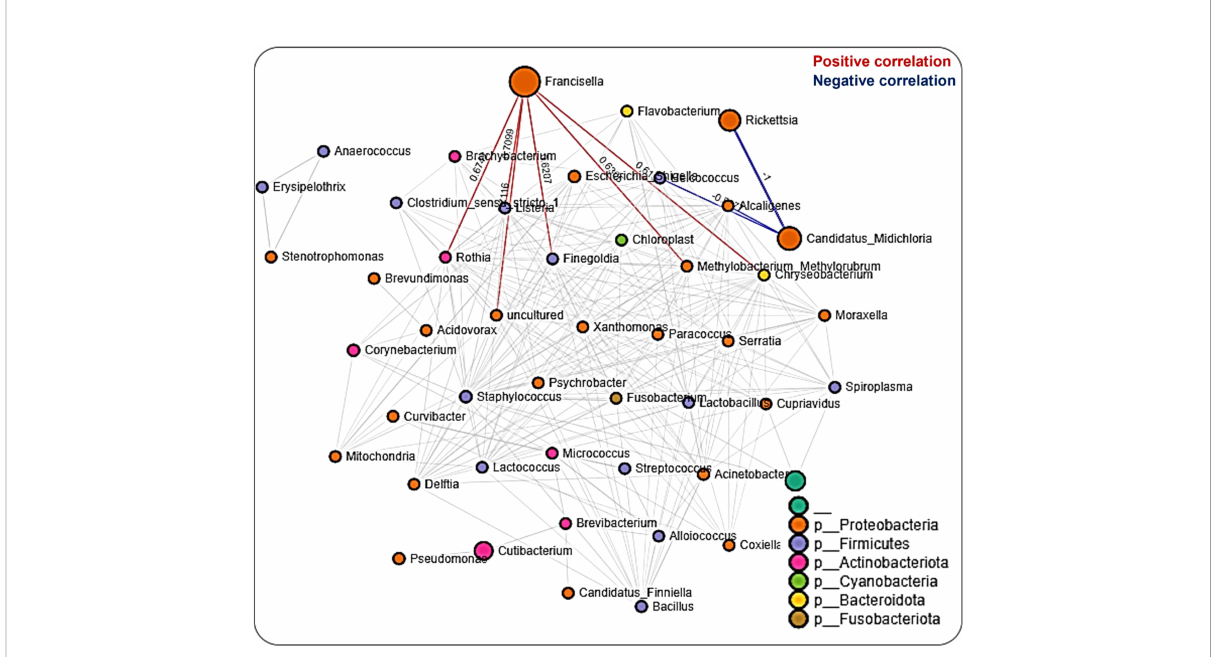
FIGURE 6 Correlation network analysis in the salivary glands of Am. maculatum ticks. Correlation network generated using the SparCC algorithm. Correlation network with nodes representing taxa at the family level and edges representing correlations between taxa pairs. Node size correlates with the number of interactions in which a taxon is involved, and the line color represents either positive (red) or negative (blue) correlations. The color-coded legend shows the bacterial family to which each taxon